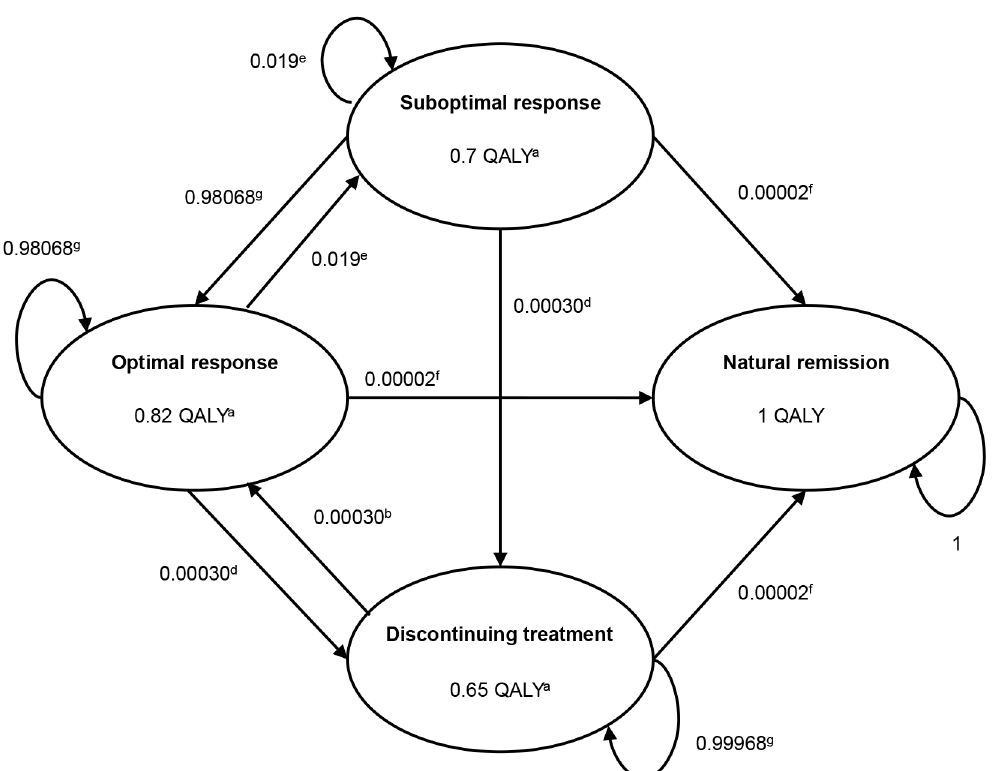
Fig 3. Markov model ER-MPH treatment with daily transition probabilities and utilities on an annual basis (QALY). QALY = Quality adjusted life years a Source: Lloyd et al. (2011) [19] b Source: Wong et al. (2009) [18] c Source: Expert panel Faber et al. (2008) [2] d Source: Faber et al. (2008) [2] e Source: Steele et al. (2006) [21] f Source: Biederman et al. (2000) [20] g Source: Remaining probabilities